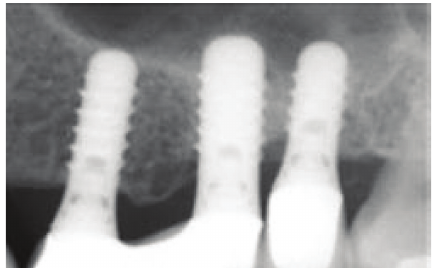
Figure 6: Periapical radiograph after two years of prosthetic loading showing a stable clinical situation in the area around the apex of the implants. A dome-shaped structure was apparent at the sites of the first and second